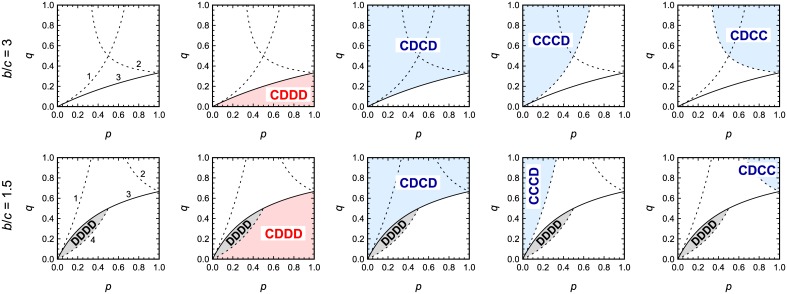
Analytical classification of indirect reciprocity with public and private interactions.Parameter regions for the most cooperative, evolutionarily stable action rules are shown. p denotes the frequency of public interactions; q denotes the probability that a private interaction is observed. Perfect cooperation (using CDCD) is realized above the solid line labeled as ‘3’, whereas only partial cooperation (using CDDD) is achieved below. There are also parameter regions where the lenient strategies, CCCD and CDCC, are ESS. For b/c < 2 there exists a parameter region where no ESS other than DDDD is found (shown in gray). The curves are given by 1: q = p/[(r − 1)(1 − p)], 2: q = p/[(r + 1)p − 1], 3: q = p/(p + r − 1), and 4: q = (r − 1)p/(1 − p), where r ≡ b/c.